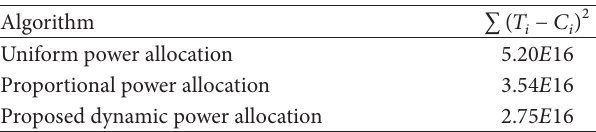
Table 4: System’s total squared difference for the three algorithms in Scenario 2.